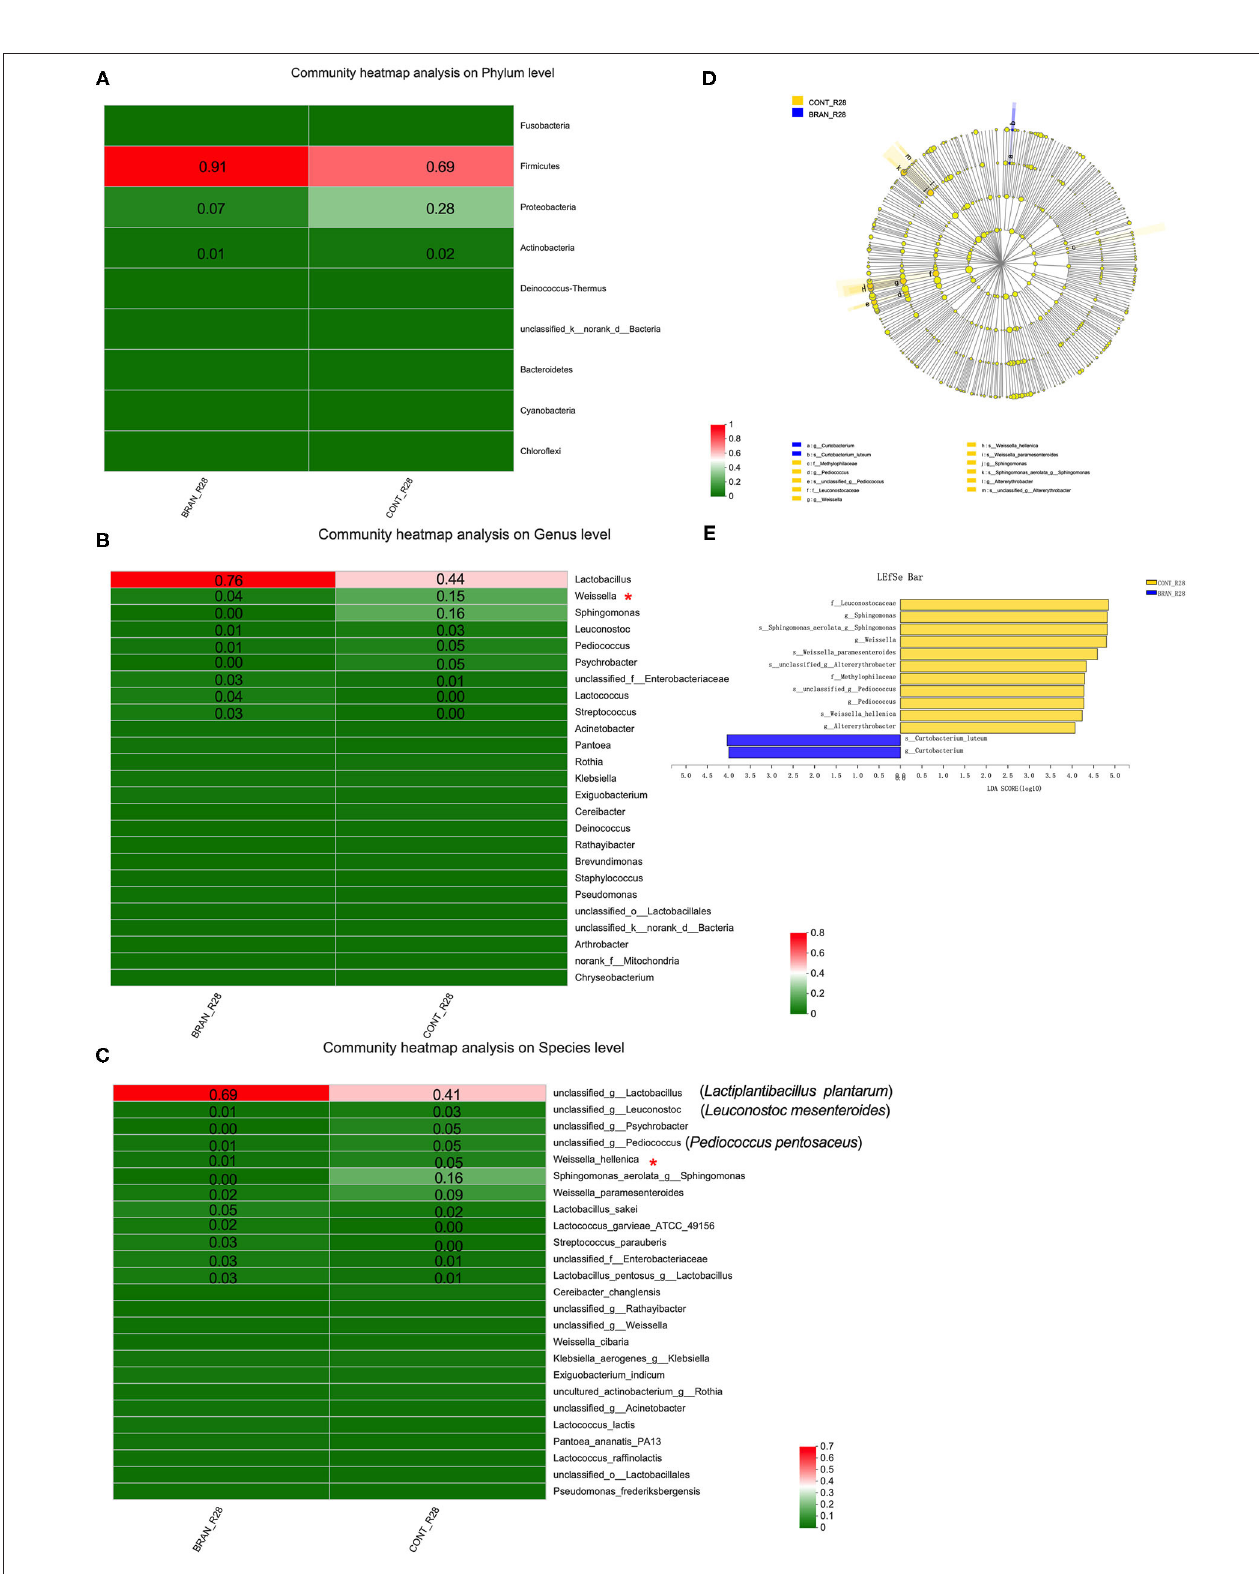
FIGURE 5 | Effect of wheat bran on microbial composition, showing the heat maps of the mean relative abundance of the prominent phyla (A) , genera (B) , and species (C) in the ripe pickled radishes on the 28th day (relative abundance > 0.01 was marked). A Wilcoxon rank-sum test was used to compare bacterial quantity at the phylum and genus levels between the CONT and BRAN groups, and significant differences are marked by * p < 0.05. The LEfSe analysis of microbial abundance from order to species level is shown in (D) , and LDA score assessments of the size differentiations between the CONT and BRAN groups, with a score threshold of 4.0, are shown in (E)